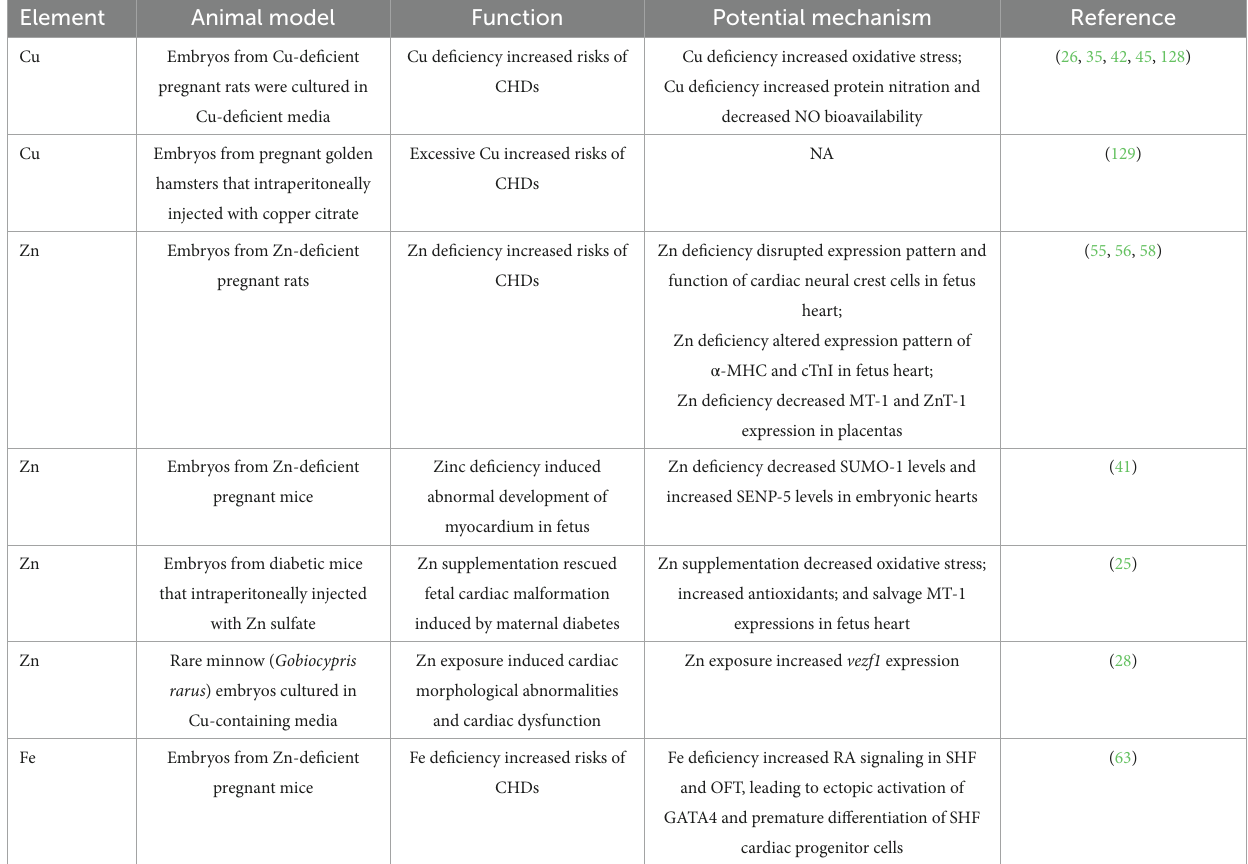
TABLE 2 Summary of laboratory-based studies reporting the relationship between essential trace element exposure and CHDs.